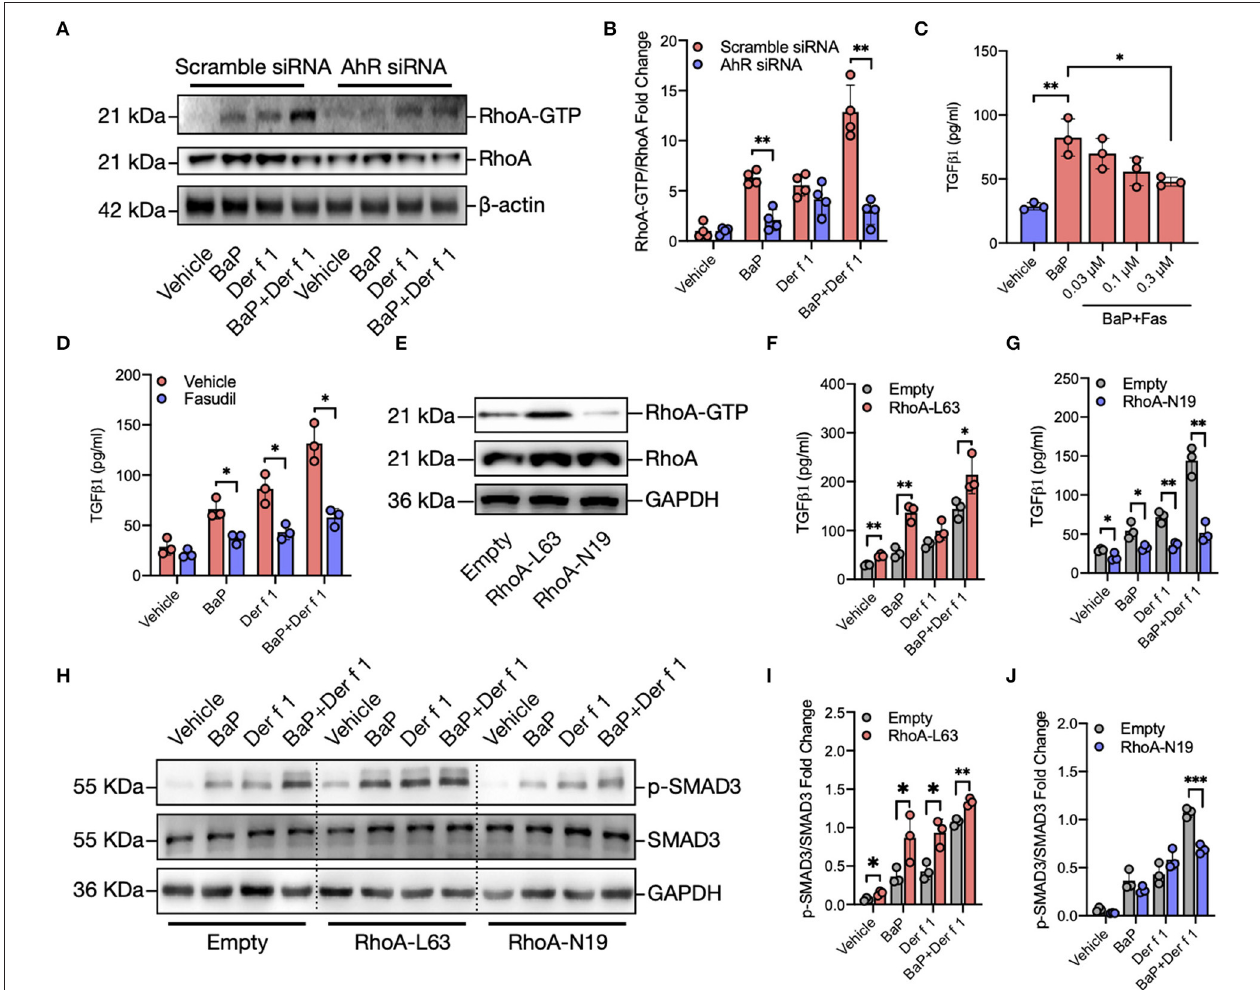
FIGURE 4 | RhoA mediates the regulation of AhR on BaP co-exposure-induced TGF β 1 production and signaling activation. (A) Western blot analysis of RhoA-GTP expression in BaP (1 µ M) and Der f 1 (30 µ g/ml) or combination-treated 16HBECs with or without AhR knockdown. (B) Quantitative analysis of Western blots in (A) . (C) Levels of TGF β 1 in supernatants of BaP-treated 16HBECs with or without fasudil at varying doses (0.03–0.3 µ M). (D) Levels of TGF β 1 in supernatants of BaP co-exposure-treated 16HBECs in the presence or absence of fasudil (0.3 µ M). (E) Western blot analysis of RhoA-GTP expression in 16HBECs expressing either a constitutively active RhoA (RhoA-L63) or dominant-negative RhoA (RhoA-N19). (F,G) Levels of TGF β 1 in supernatants of BaP (1 µ M), Der f 1 (30 µ g/ml), and co-exposure-treated 16HBECs expressing either RhoA-L63 (F) or RhoA-N19 (G) . (H–J) Western blot analysis of p-Smad3 expression in BaP (1 µ M), Der f 1 (30 µ g/ml), and co-exposure-treated 16HBECs expressing either RhoA-L63 (H,I) or RhoA-N19 (H,J) . Data represent mean ± SEM. * p < 0.05, ** p < 0.01, and *** p <